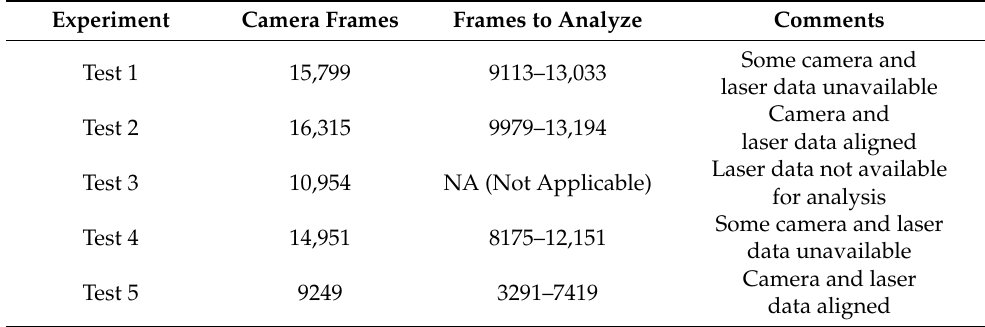
Table 1. Summary of the five field experiments, camera data collected, and selection for analysis.